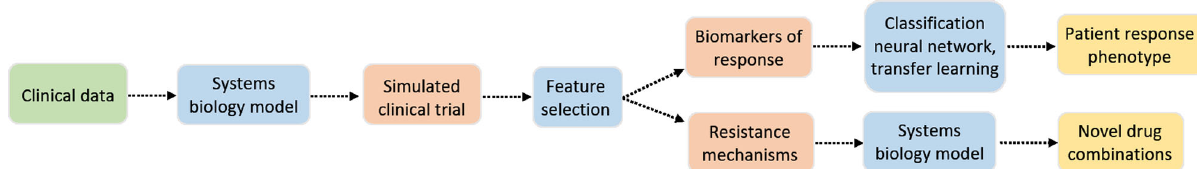
Fig. 1 Overview of the data and methodology used throughout the work. A small clinical data set is used to develop and calibrate a systems biology model of anti-PD-1 immunotherapy, which is then employed to generate large simulated clinical trials. Feature extraction techniques are applied to the simulated data to determine biomarkers of response to therapy as well as potential mechanisms of drug resistance. The response features are used as inputs into a classi fi cation neural network (C-SBINN), which utilizes transfer learning, to predict the patient response phenotype. The identi fi ed mechanisms of intrinsic drug resistance are leveraged to develop novel drug